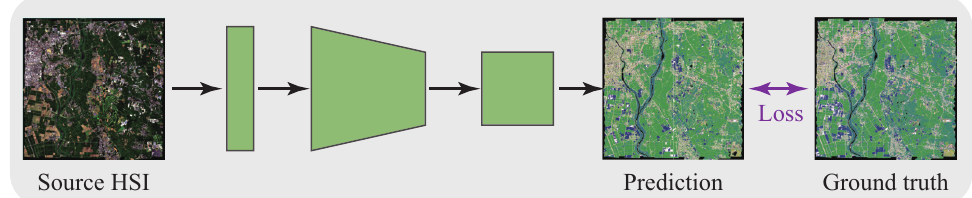
Figure 1. Schematic of pre-training on source HSIs (the Chikusei dataset is presented as an